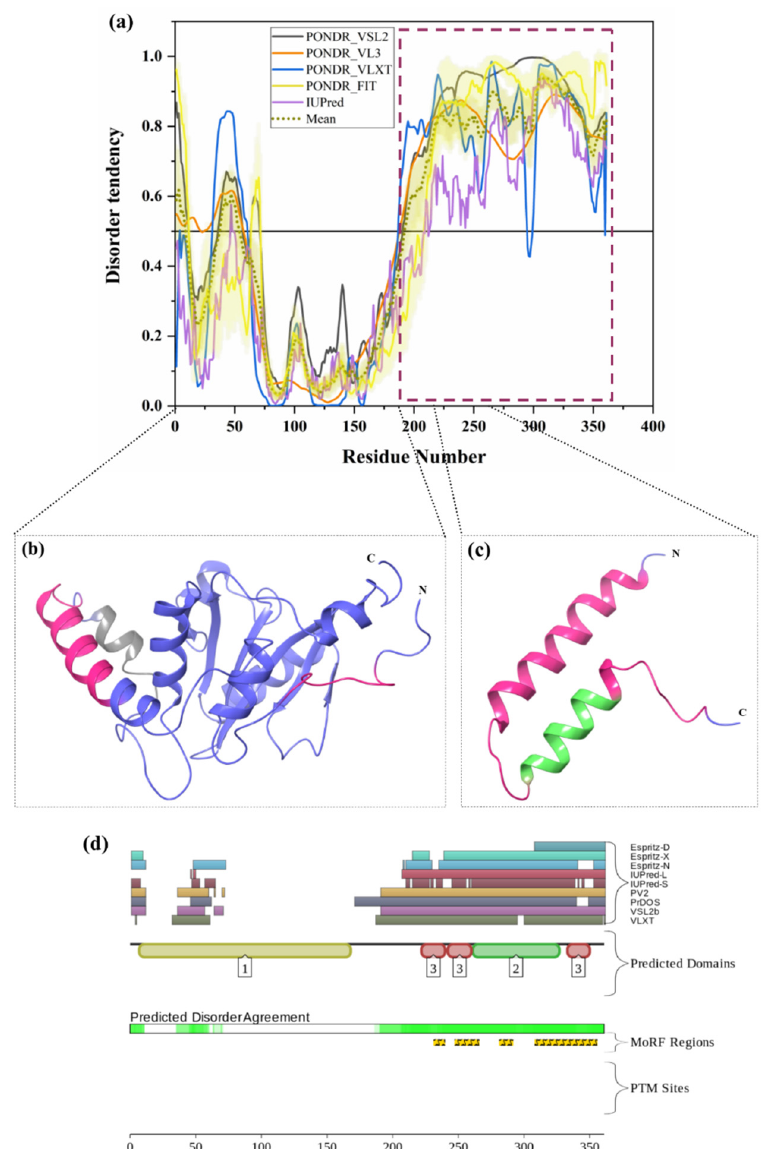
Figure 9. Intrinsic disorder predisposition of ataxin-3. ( a ) Intrinsic disorder profile generated for ataxin-3 (UniProt ID: P54252) by a set of per-residue disorder predictors, such as PONDR ® VSL2, PONDR ® VL3, PONDR ® VLXT, PONDR ® FIT, and IUPred. ( b ) Crystal structure of the Josephin domain of ataxin-3 (PDB ID: 2AGA). ( c ) NMR solution structure of the tandem UIM domain of ataxin-3 (PDB ID: 2KLZ). In Plot ( a ), disorder profiles generated by set of disorder predictors, such as PONDR ® VSL2, PONDR ® VL3, PONDR ® VLXT, PONDR ® FIT, and IUPred, are depicted by black, orange, blue, yellow, and purple curves respectively. A mean disorder profile calculated from average of five predictor-specific per-residue disorder profile is shown by the olive color curve. Predicted disorder scores above 0.5 are considered as disordered residues / regions. The light-olive shadow around the mean curve represents the error distribution for the mean. The light-yellow shadow around the PONDR ® FIT curve shows the error distribution for PONDR ® FIT. In Plots ( b ) and ( c ), ataxin-3 is represented by a faded blue color; disordered residues are shown by a salmon pink color. In ( b ), the position of MoRFs (residues 56–65) predicted by the MoRFCHiBi_web server is shown by a gray color (PDB ID: 2AGA). In ( c ), the position of MoRFs (residues 246–255) predicted by the MoRFCHiBi_Web server is represented as MoRFs lying in IDPRs by faded green color (PDB ID:2KLZ). ( d ) The D2P2 server-based functional disorder profile is shown.